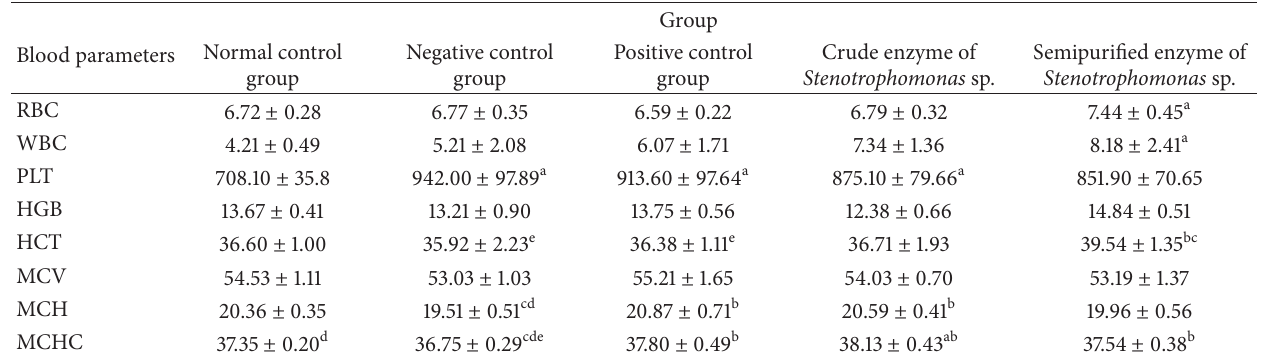
Blood parameters